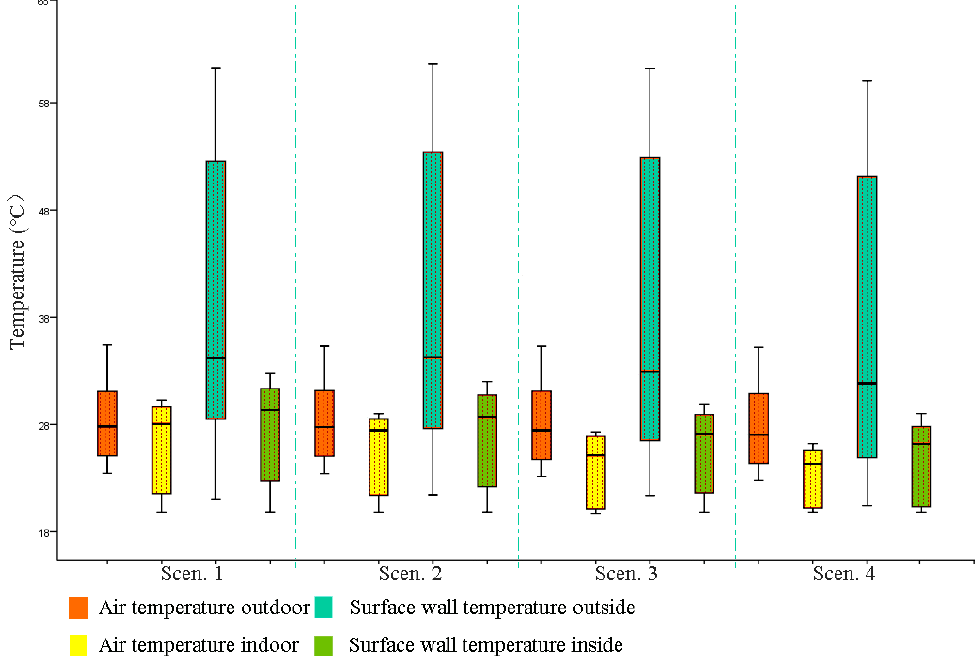
Figure 5. Distribution characteristics of the 24-h data.